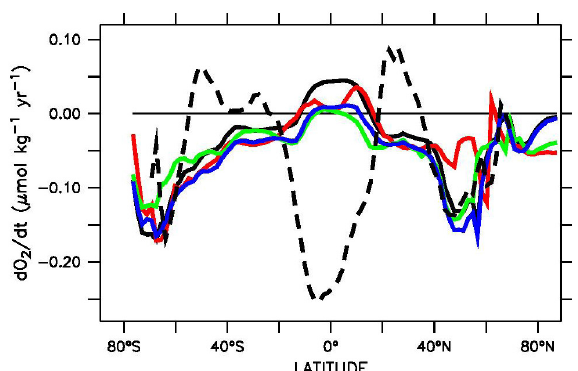
Fig. 5. Zonally averaged change in observed oxygen at 300dbar (dashed black line) and simulated oxygen at 300dbar for the stan- dard configuration of Duteil and Oschlies (2011) with a diapycnal background diffusivity of k bg =0.15cm 2 s − 1 and constant (Red- field) C:N stoichiometry (black curve, Fig. 4a), for a much reduced background diffusivity of k bg =0.01cm 2 s − 1 and constant C:N sto- ichiometry (red curve, Fig. 4c), for increased background diffusivity of k bg =0.3cm 2 s − 1 and constant C:N stoichiometry (green curve, Fig. 4d), and for k bg =0.15cm 2 s − 1 and pCO 2 -sensitive C:N ratios as used by Oschlies et al. (2008) (blue